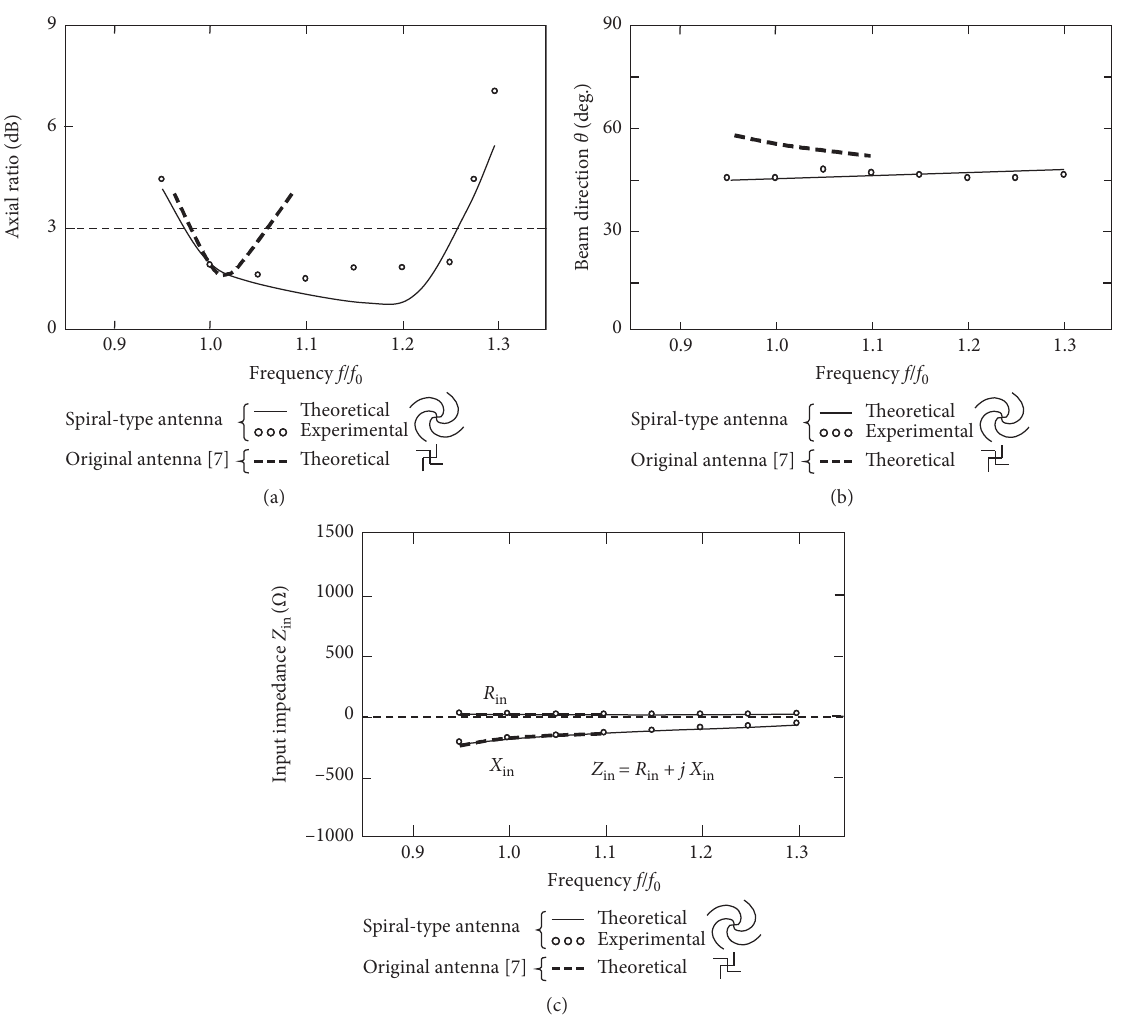
Figure 4: Frequency responses of axial ratio, beam direction, and input impedance of a spiral-type antenna for ( d 256), together with those of the original antenna [7]. (a) Axial ratio. (b) Beam direction. (c) Input